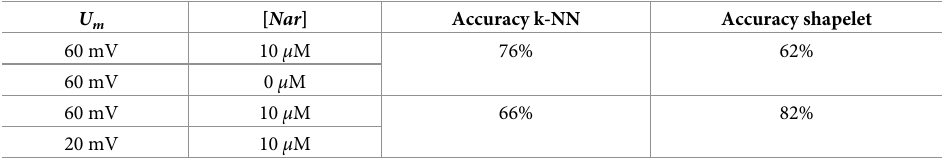
Table 3. The prediction accuracies obtained with the k–NN and shapelet methods for the groups of experimental data representing different types of channel activating stimuli (i.e. [Nar] and U m ). U